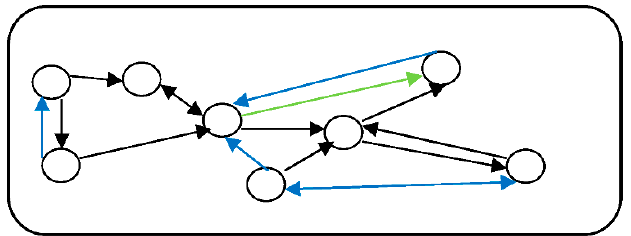
Figure 2. Conceptual space with inner relations between concepts.